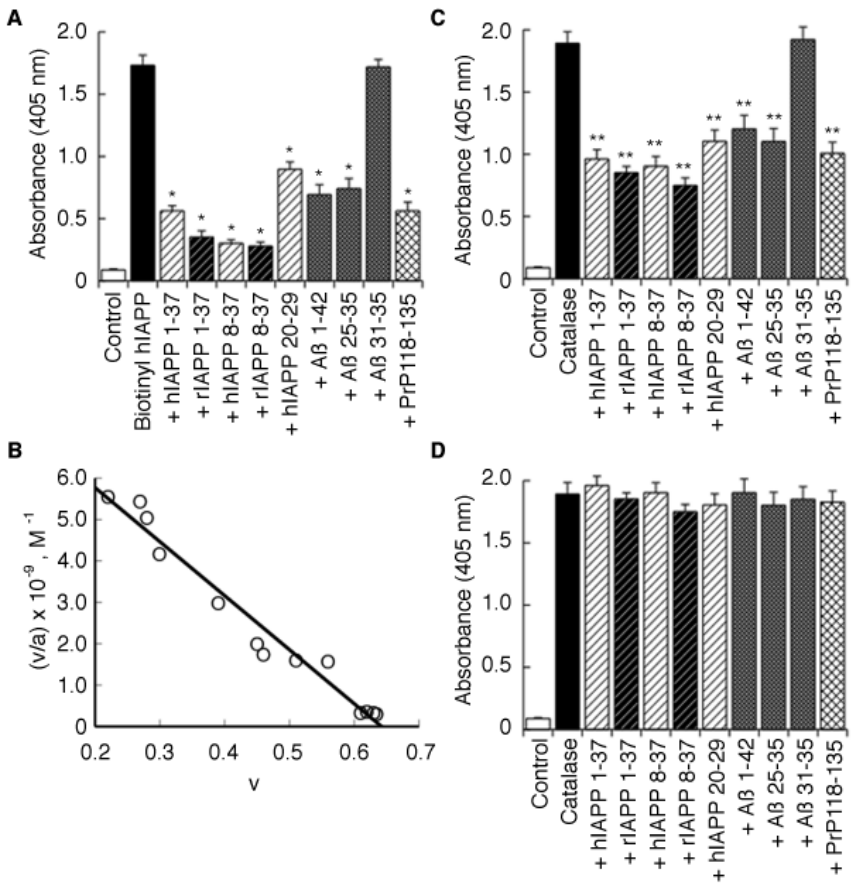
FIGURE 6 . IAPP binding to catalase. (A) Binding of biotinyl human IAPP 1-37 to immobilized catalase in the presence of unlabeled human IAPP, Aβ, or PrP peptides was inhibited. * = p < 0.05 (one-way ANOVA) vs. biotinyl human IAPP 1-37 alone. (B) Scatchard plot of binding of biotinyl human IAPP 1- 37 to catalase in the presence of unlabeled human IAPP 1-37. Data were plotted using v against v/a, where v =[(A 0 - A) / A 0 ]; A 0 = absorbance in absence of unlabeled peptide, A = absorbance in presence of unlabeled peptide, and a = concentration of unlabeled peptide added. (C) Catalase binding to human IAPP 1-37–coated ELISA plates in the presence of unlabeled human IAPP, Aβ, or PrP peptides was reduced. ** = p < 0.05 (one-way ANOVA) vs. catalase alone. (D) Human IAPP 1-37–coated ELISA plates preincubated in the presence of unlabeled human IAPP, Aβ, or PrP peptides prior to washing and addition of catalase showed no differences in the binding of